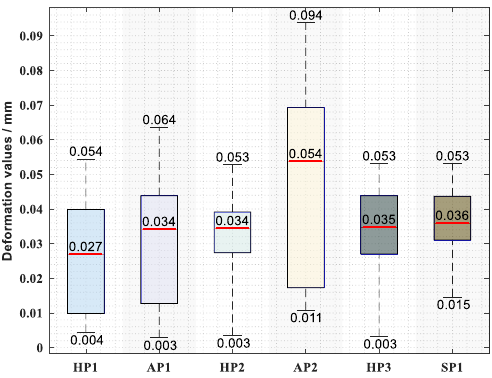
Figure 12. Displacement perception error statistics of all the positioners.